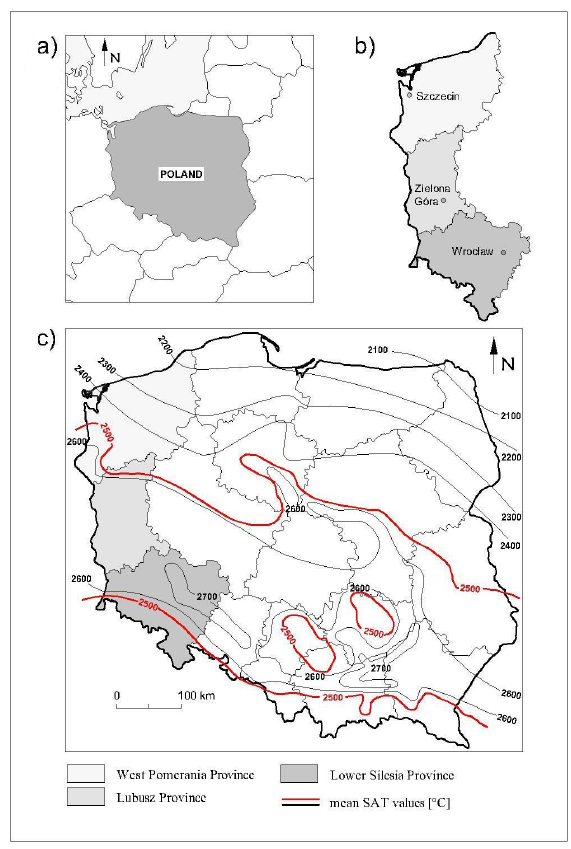
Figure 1. Provinces (NUTS-2) in Poland with examined western ones: geographical location of Poland ( a ), location of meteorological stations ( b ) and isolines of sum of active temperatures (SATs) ( c ).